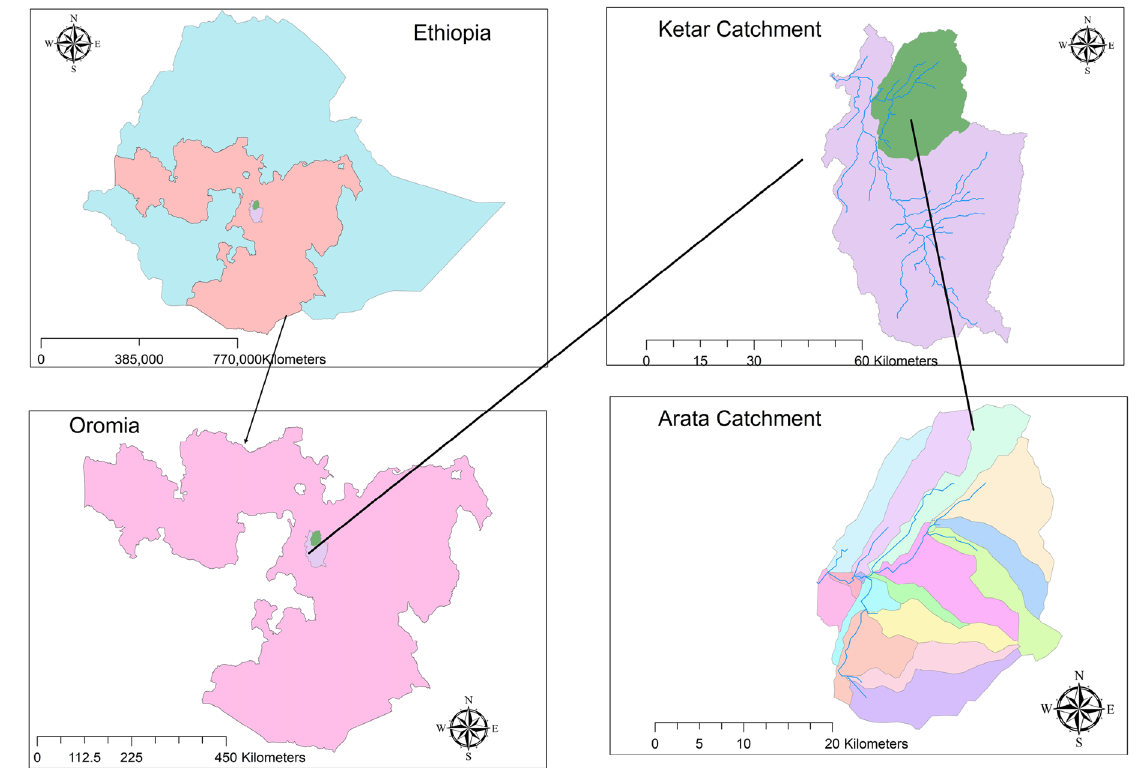
Fig. 1 Arata catchment location map